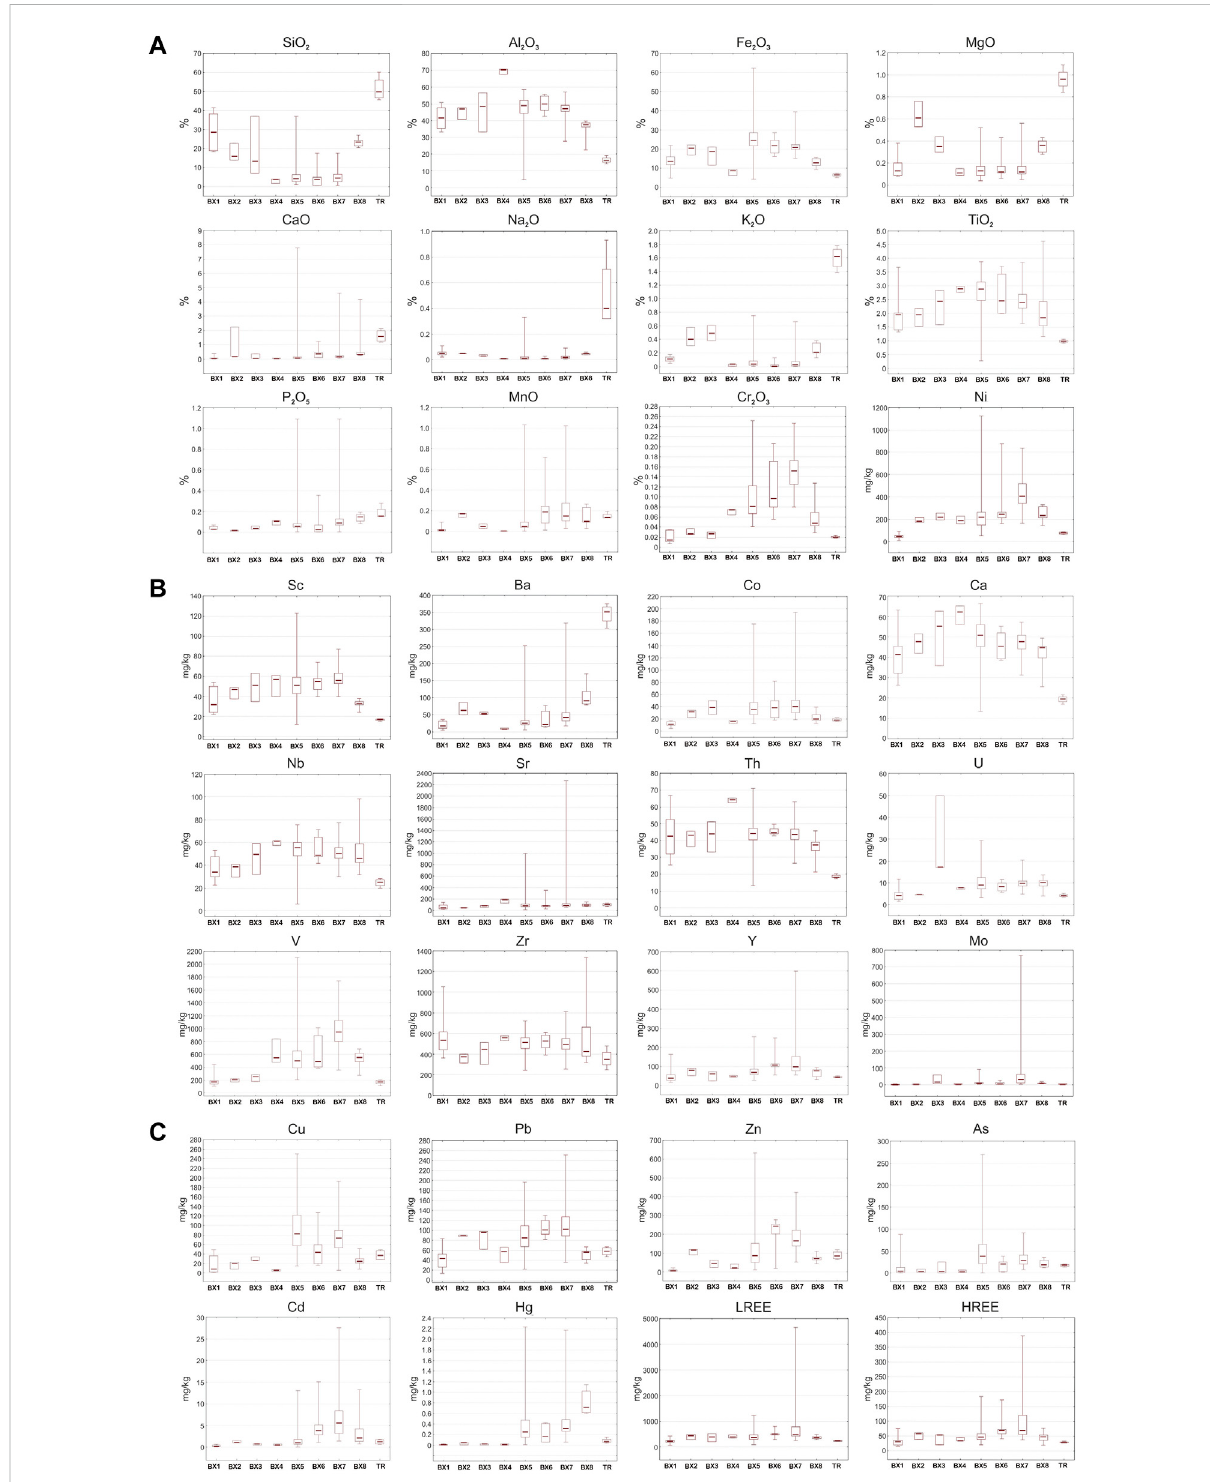
FIGURE 5 Box-and-whisker plots by groups, which represent univariate statistics of geochemical data (descriptor variables — min-max; median; and fi rst and third quartile values) for each karst bauxite horizon (BX1-BX8) and soils (TR): (A) The abundances of major elements (expressed in %) and Ni (expressed in mg/kg). (B) The abundances of trace elements (expressed in mg/kg): Sc, Ba, Co, Ga, Nb, Sr, Th, U, V, Zr, V, Mo. (C) The abundances of trace elements (expressed in mg/kg): Cu, Pb, Zn, As, Cd, Hg, and LREE and